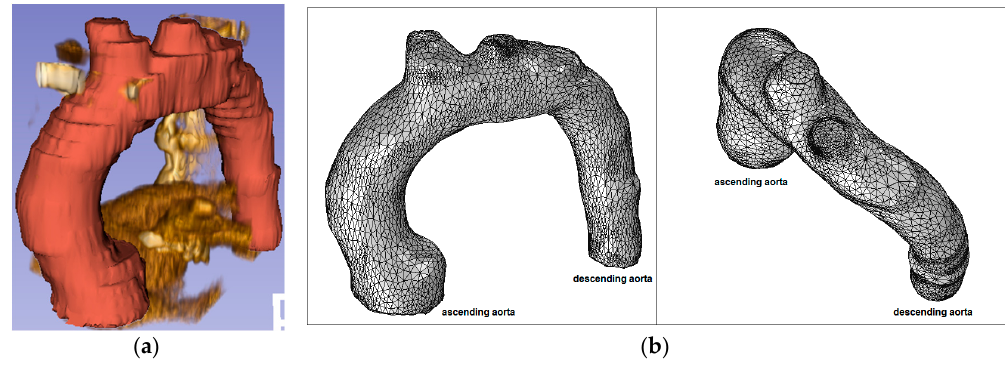
Figure 8. Healthy patient (pilot): ( a ) CT data and segmentation; and ( b ) mesh.